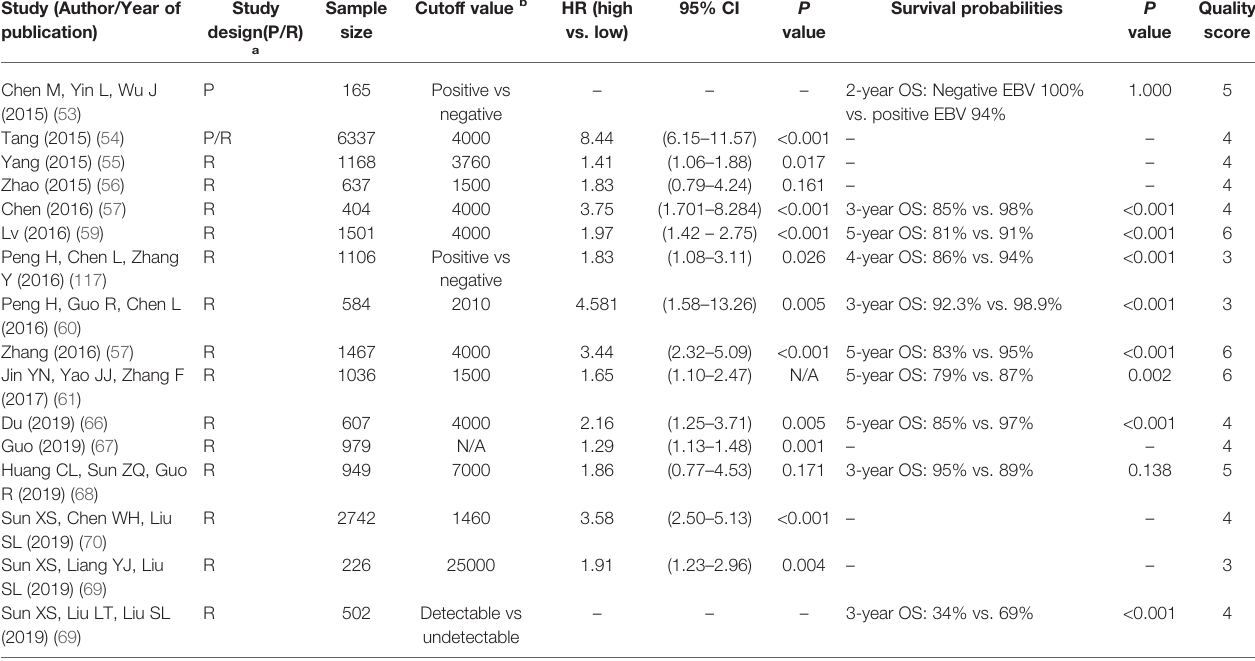
TABLE 3 | Association of overall survival with the pretreatment EBV DNA level